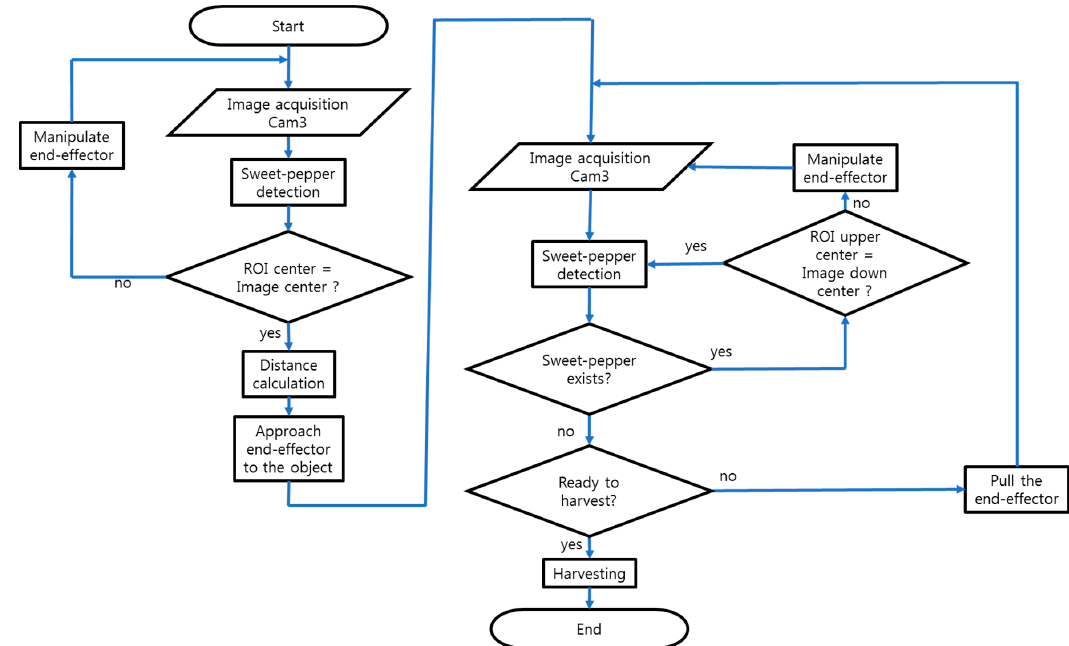
Figure 10. Flow chart of harvesting algorithm.